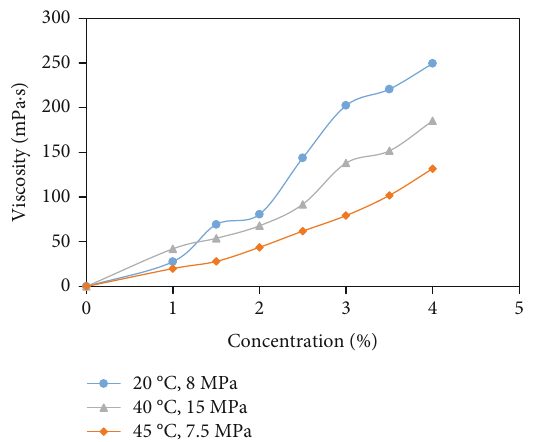
Figure 2: Curves of thickener concentration versus CO